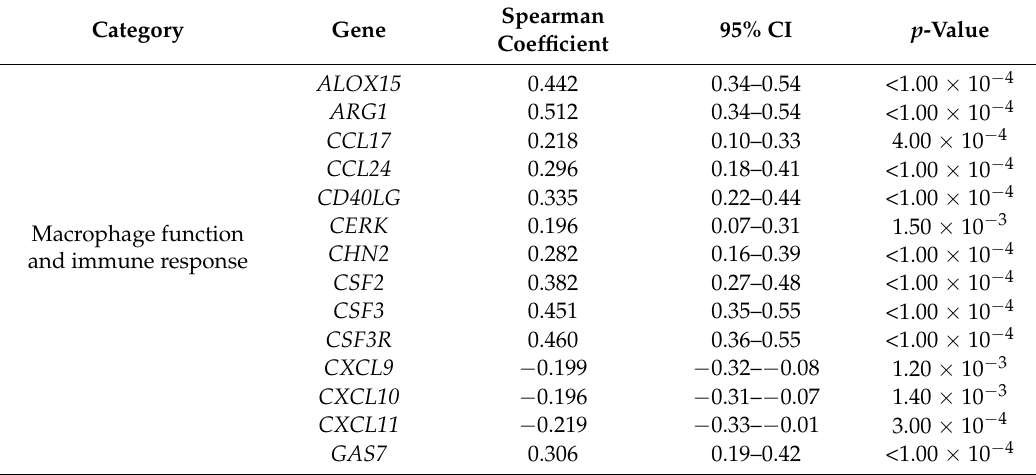
Figure 4. Oncostatin M (OSM) expression levels in different molecular subtypes of breast cancer. ( A ) Graphs showing OSM and OSM receptor ( OSMR ) expression levels in estrogen receptor (ER)-negative/human epidermal growth factor receptor 2 (HER2)-negative breast cancer and luminal/HER2-positive subtypes; ( B ) Representative immunohistochemical images of OSM expression in triple-negative and luminal breast tumors. Scale bars represent 50 µ m; ( C ) Quantification of staining intensity. Data are presented as mean ± standard deviation (SD). ** p < 0.01. Table 3. Most significant correlations of OSM expression with cancer-related genes in ER-negative/HER2-negative breast cancers ( n = 262).